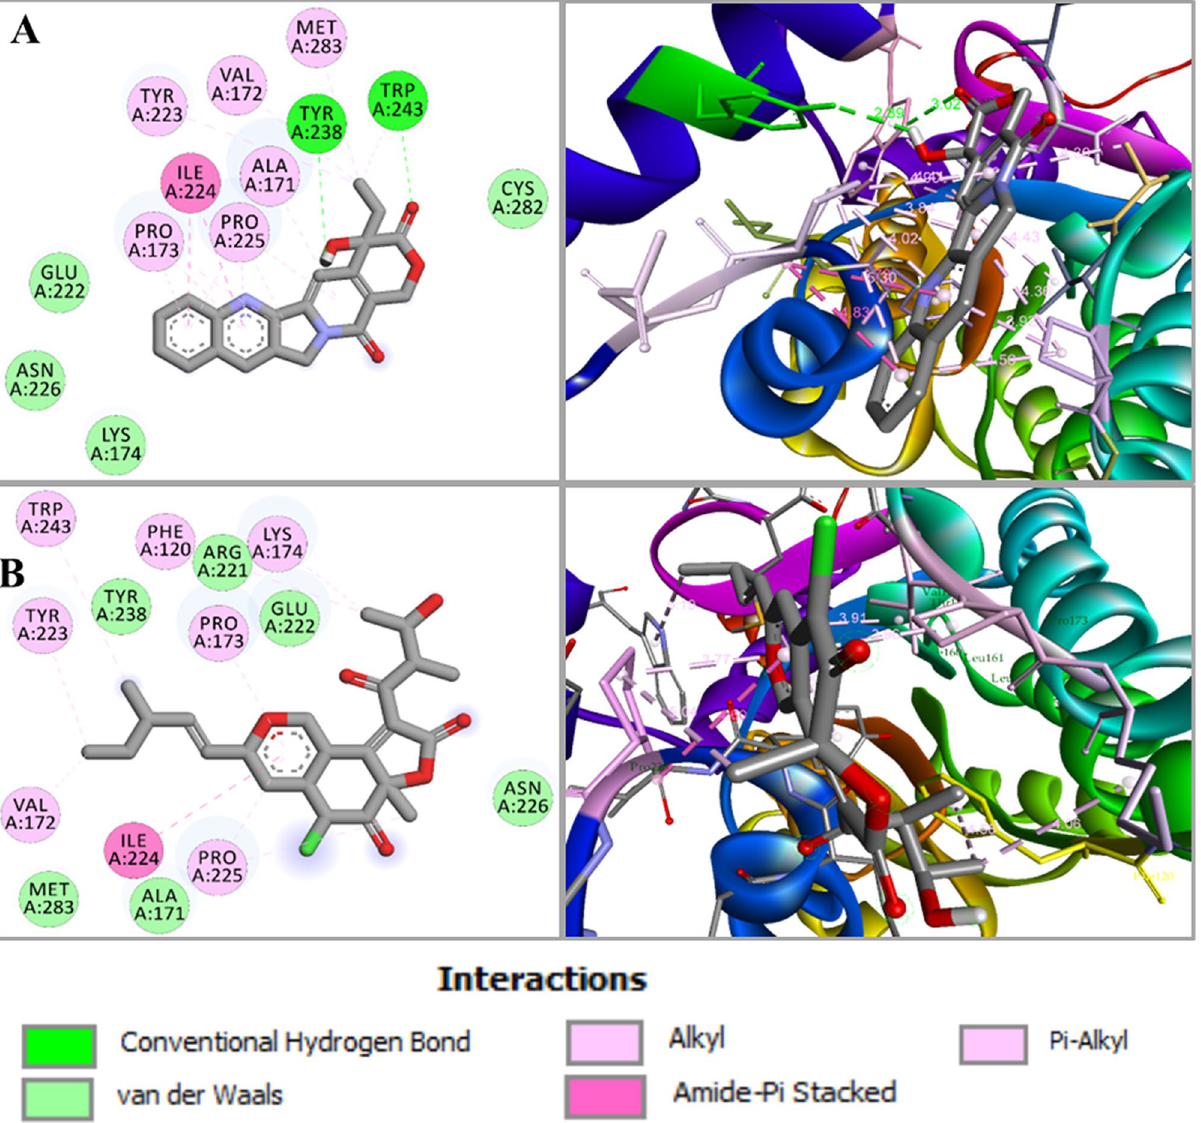
Figure 2. Molecular docking of the screened compounds. ( A ) Camptothecin docked in complex with trihydroxynaphthalene reductase (PDB ID: 1YBV). Camptothecin showed hydrogen bond with residues A:TRP243 and A:TYR238, and hydrophobic non bonded interactions formed with A:ILE224, A:VAL172, A:PRO225, A:TYR223, A:TRP243, A:PRO173, A:ALA171 and A:MET283. A 2D interaction analysis is shown at left and 3D interaction analysis shown at right side. ( B ) Interaction between trihydroxynaphthalene reductase and compound chaetoviridin-A